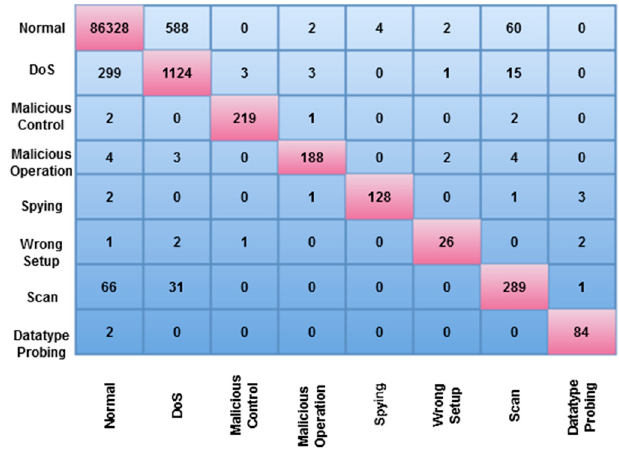
Figure 16. Confusion matrix for dataset 5.